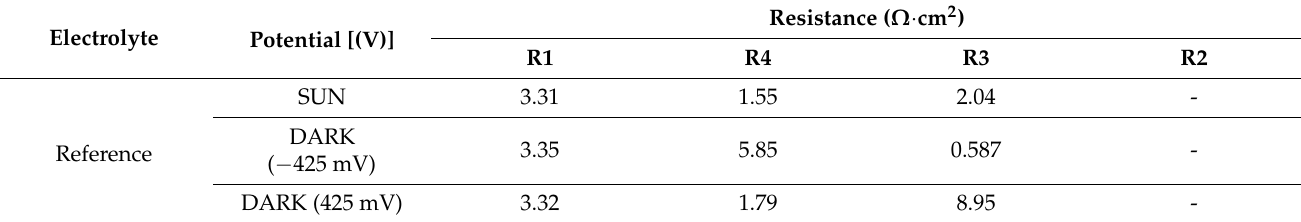
Table 2. Resistance values obtained by fitting the electrochemical impedance spectroscopy data in a determined frequency range for the different prepared eutectic mixtures at selected potential for the prepared DSSCs using eutectic mixtures plus I 2 as electrolyte [a] .